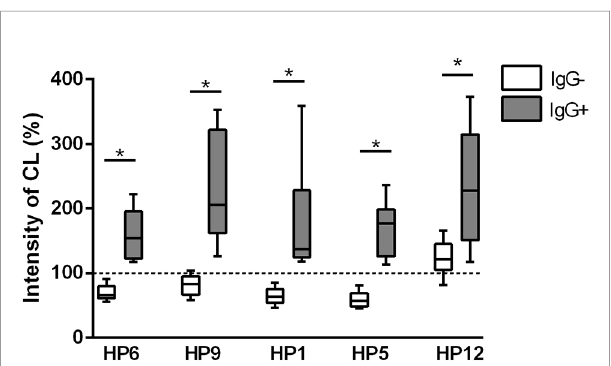
FIGURE 6 | ROS production. ROS production was measured for 1 h by chemiluminescence assay in PAMs infected with various strains of G. parasuis pre-incubated with (IgG+) or without the post-vaccinal IgG (IgG-). Data are presented as percentage of integral of the chemiluminescence signal levels compared to the non-infected PAMs. Signi fi cant difference between groups with or without the IgG is denoted by asterisk